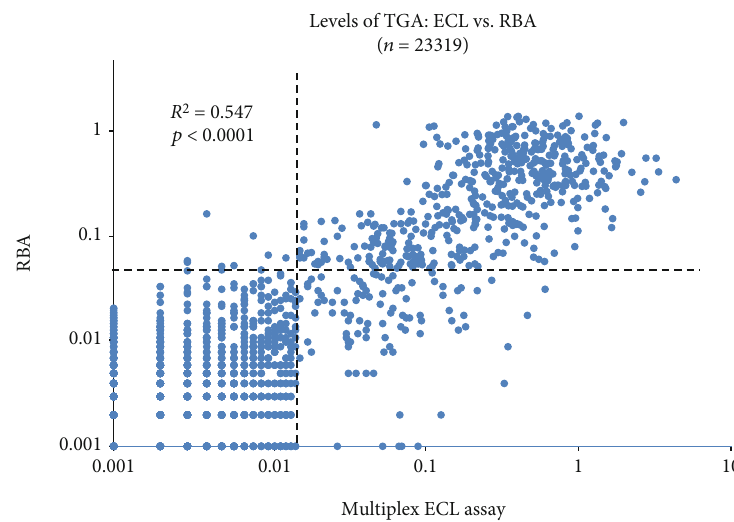
Figure 2: Levels of TGA: ECL vs. RBA on 23,319 children studied. ECL-TGA were compared with RBA-TGA in levels. The dotted lines represent the cut-o ff s for ECL-TGA and RBA-TGA, respectively. The levels of TGA from two assays were well correlated ( R 2 = 0 : 547 , p < 0 : 0001 ). Signi fi cantly more TGA were detected by ECL than RBA.